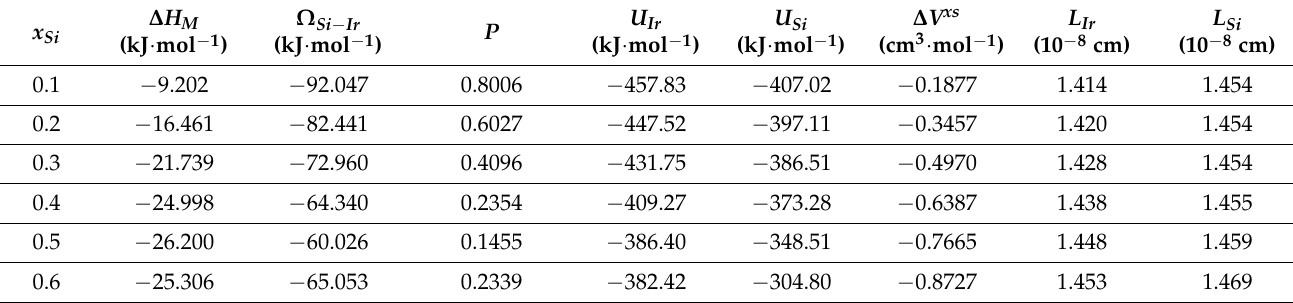
Table 1. Calculated values of the excess entropy of mixing ( ∆ S xs framework of the free volume theory. The enthalpy of mixing ( ∆ H M ) and the excess volume ( ∆ V xs ) values were calculated for T = 1873 K by Miedema’s model. (The meaning of symbols reported here is given in the Abbreviations).